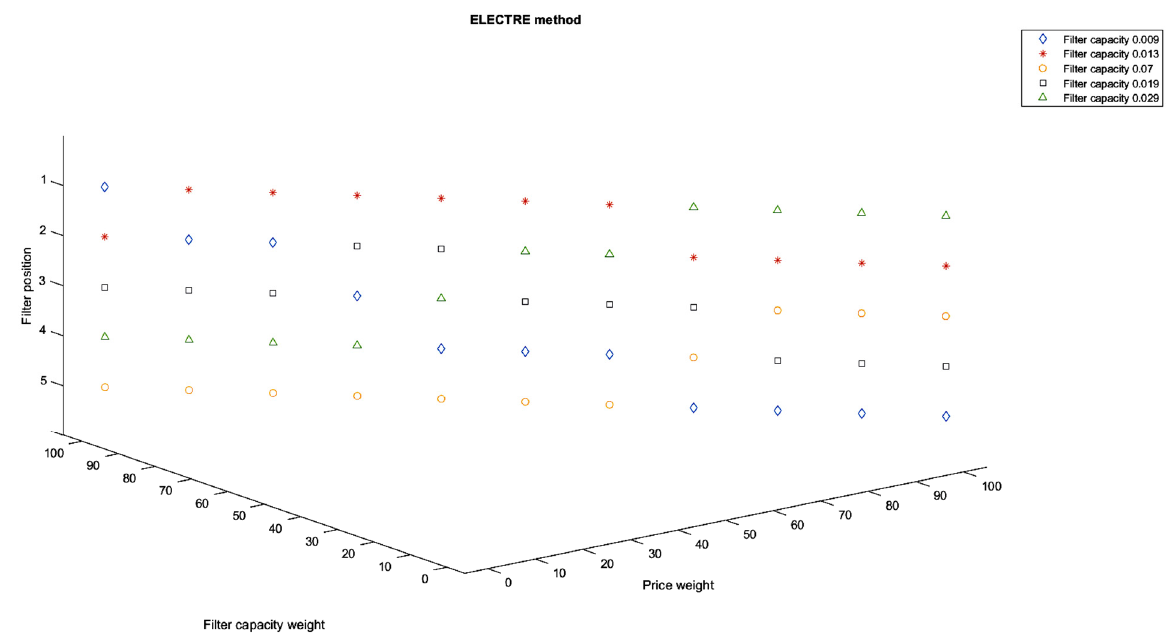
Figure 9. Filter classification with respect to different criteria weight combinations using the ELECTRE method.